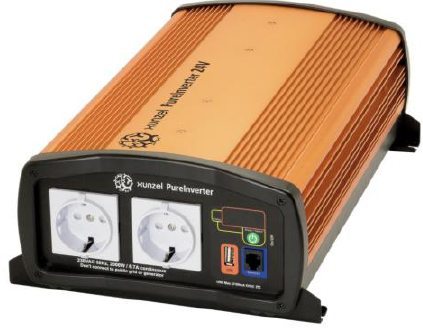
Figure 4. Inverter XJC20001255U Model.